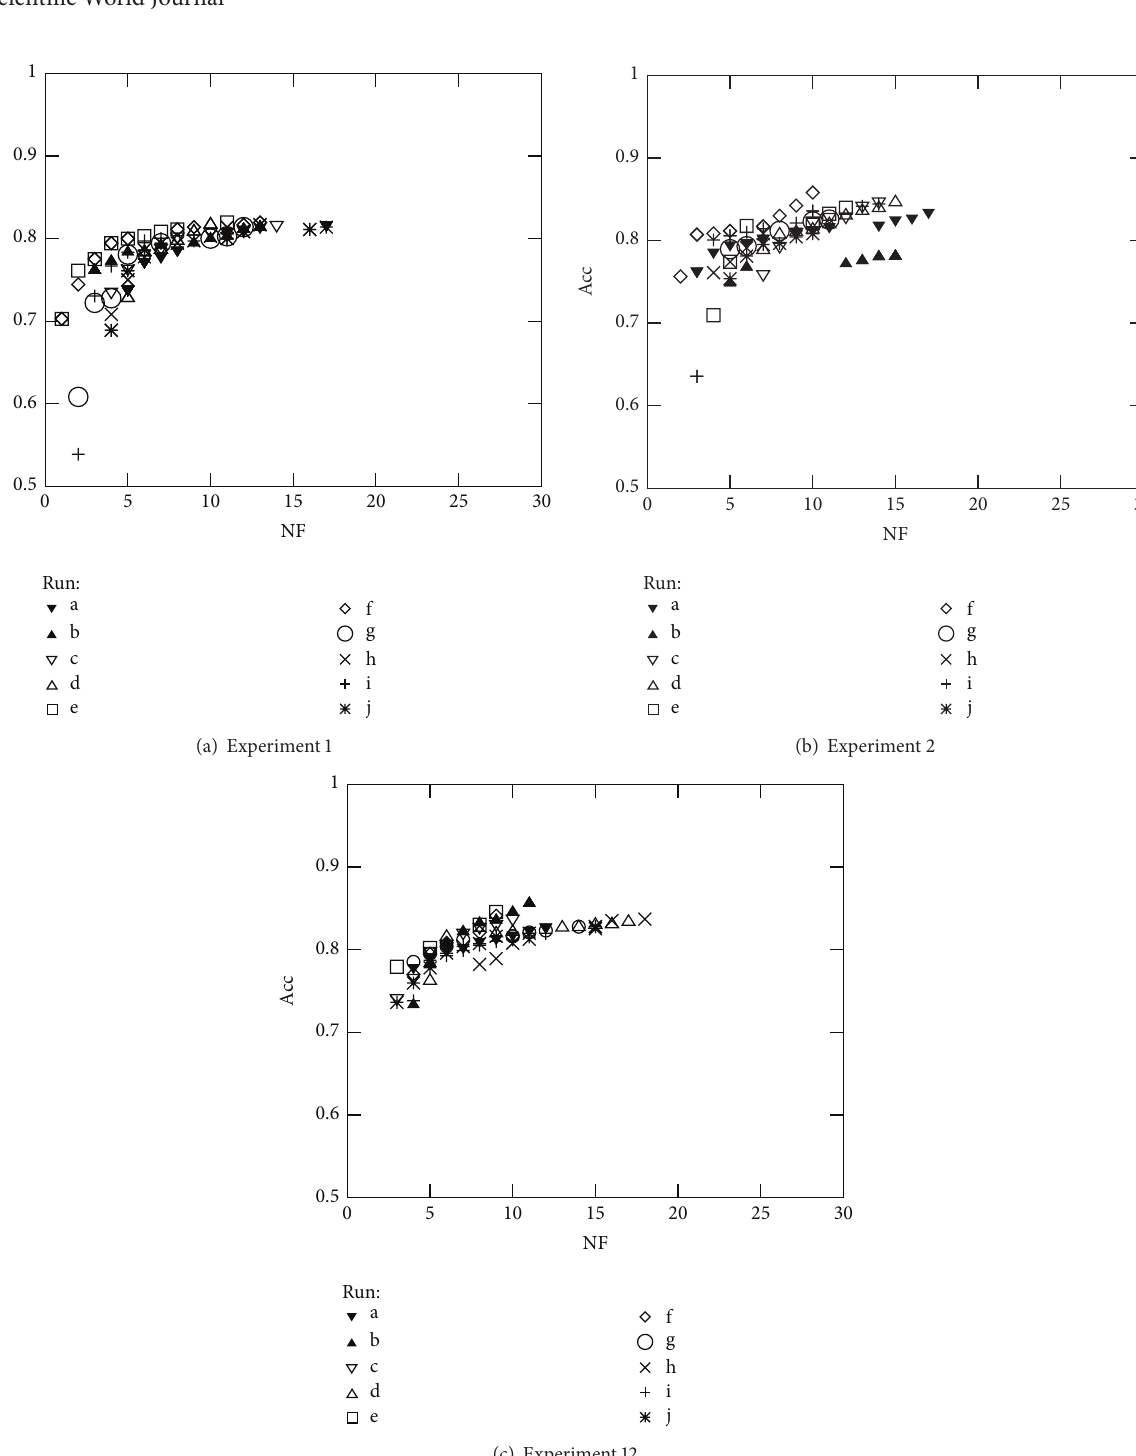
Figure 7: Optimal Pareto fronts for Diane 2005 data (10